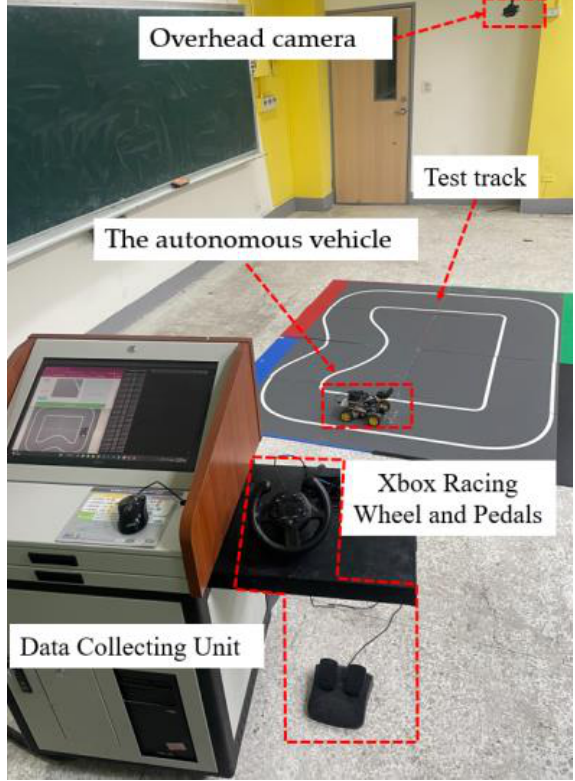
Figure 6. Photo of the system installation.